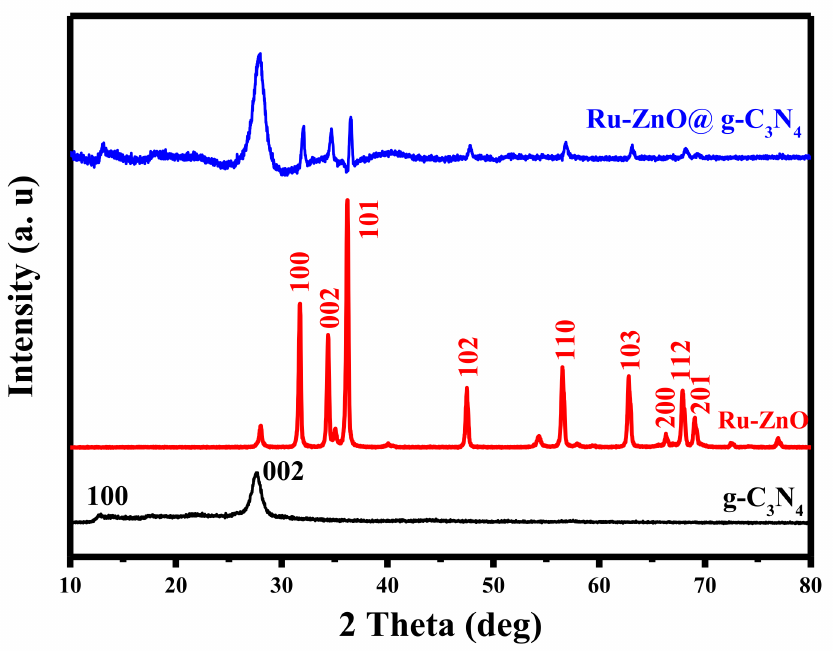
Figure 1. XRD pattern of g-C 3 N 4 , Ru-ZnO, and Ru-ZnO@g-C 3 N 4